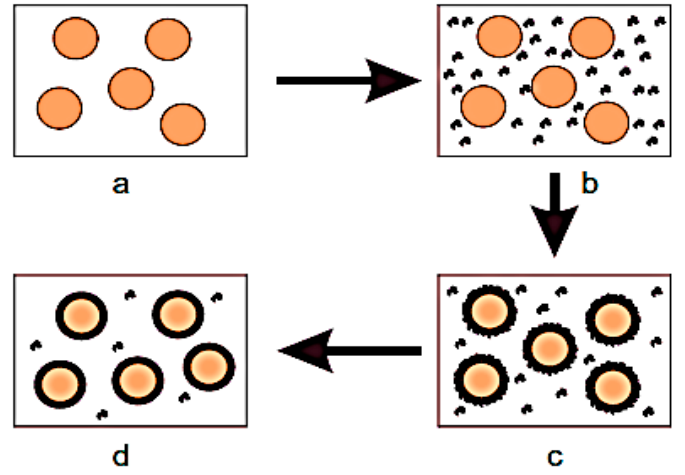
Figure 1. Stages of the complex coacervation polymerization process. ( a ) emulsifying PCM core material in water; ( b ) addition of MMA and ally-MMA monomers; ( c ) coating the core material with monomeric microparticles; ( d ) adding the initiator and capsule formation by polymerization.